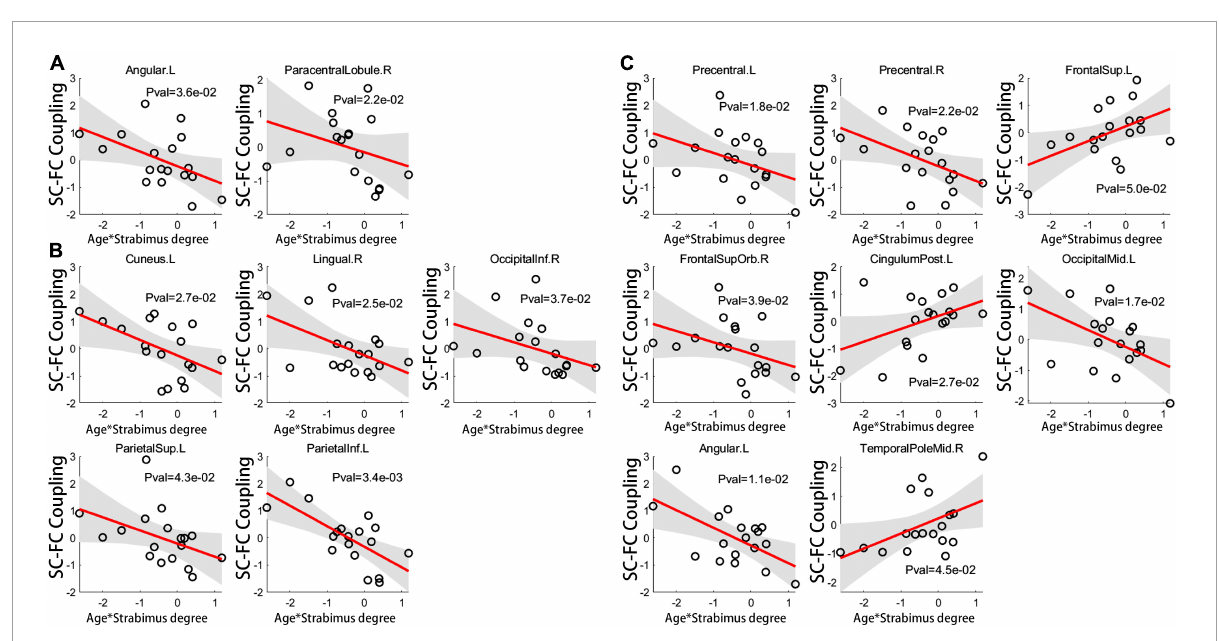
FIGURE6 The age-related regulatory effect on correlation of coupling score for global connections (A) , long connections (B) and short connections (C) with strabismus degree. For brain regions implicated in visual or sensorimotor process, the relationship between coupling score and strabismus degree became looser with age. On the contrary, for cognition-related brain regions, an age-dependent strengthened association was evident between coupling score and strabismus degree (unadjusted P < 0.05). Brain regions and their abbreviations are detailed in Supplementary Table 1 . SC, structural connectivity; FC, functional connectivity; L, left; R,